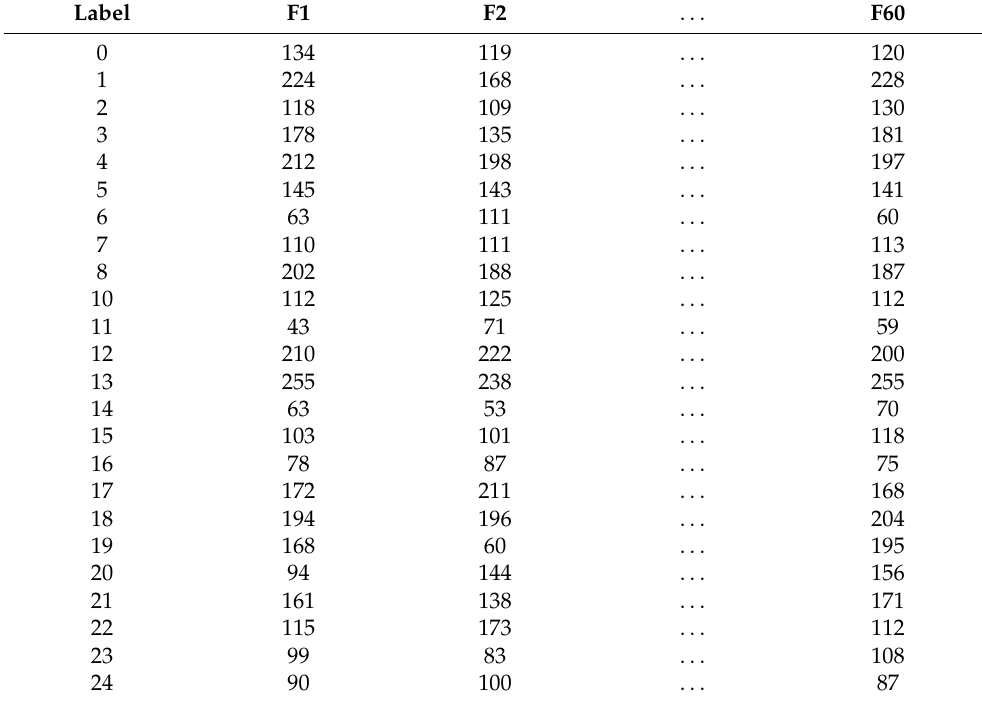
Table 2. A snapshot of the training MNIST images